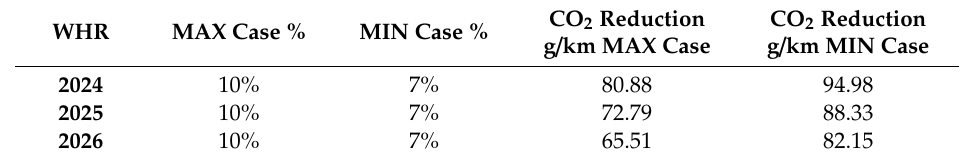
Table 6. CO 2 Reduction in Waste Heat Recovery Technology.